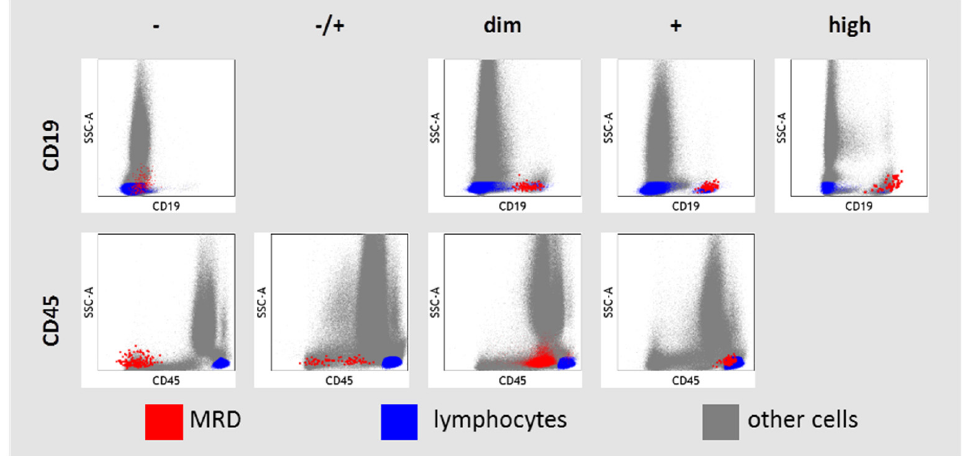
Figure 2. Description of CD19 and CD45 expression in residual blast cells (MRD—measurable re- sidual disease).